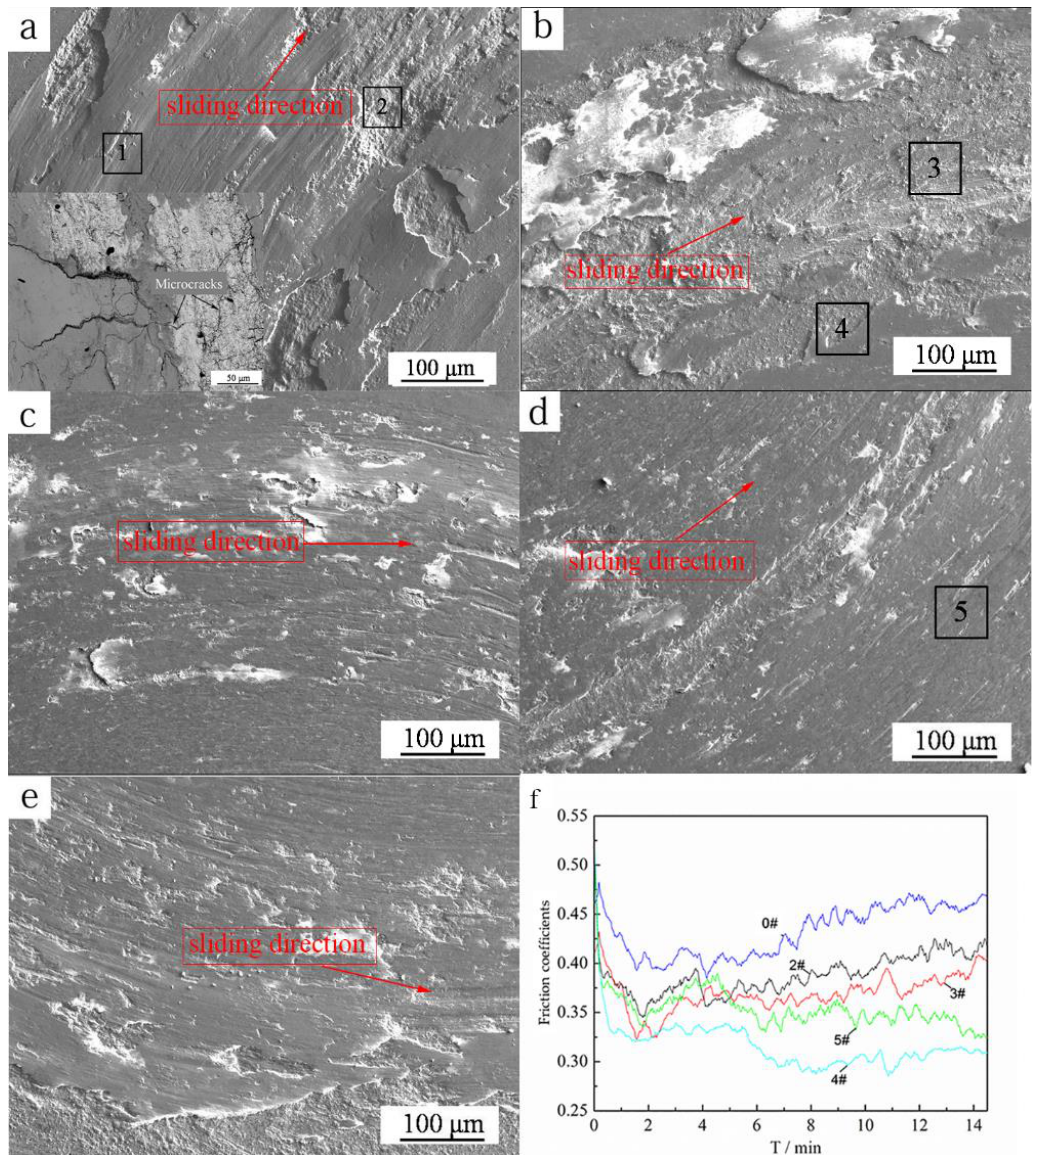
Figure 3. Micrographs of the worn surface and friction coefficient of the 35Ni15Cr Fe-based compo- sites. ( a )sample 0#; ( b )sample 2#; ( c ) sample 3#; ( d ) sample 4#; ( e ) sample 5#; ( f ) Friction coefficients. Table 2. The EDS analysis results of different area from the wear surface (wt.%).